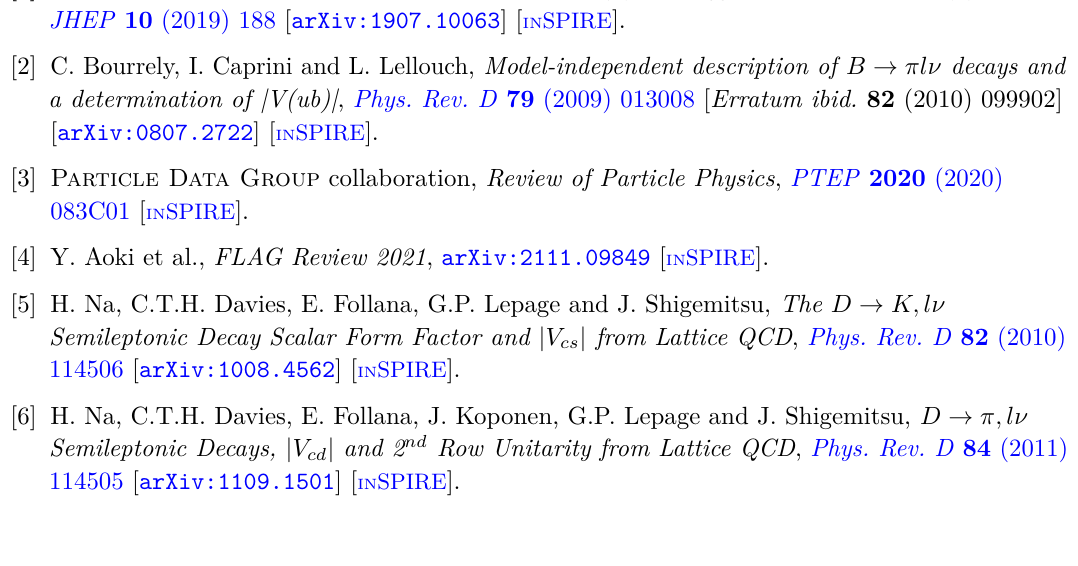
model. The color coding is the same as in figure 1. FN